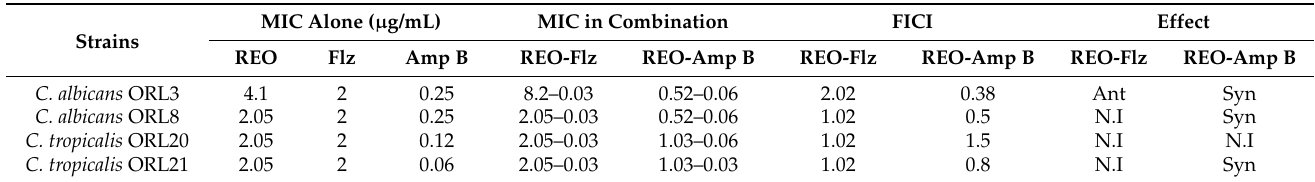
Table 3. Synergistic activity of REO in combination with fluconazole and amphotericin B. MIC Alone ( µ g/mL) MIC in Combination FICI Strains